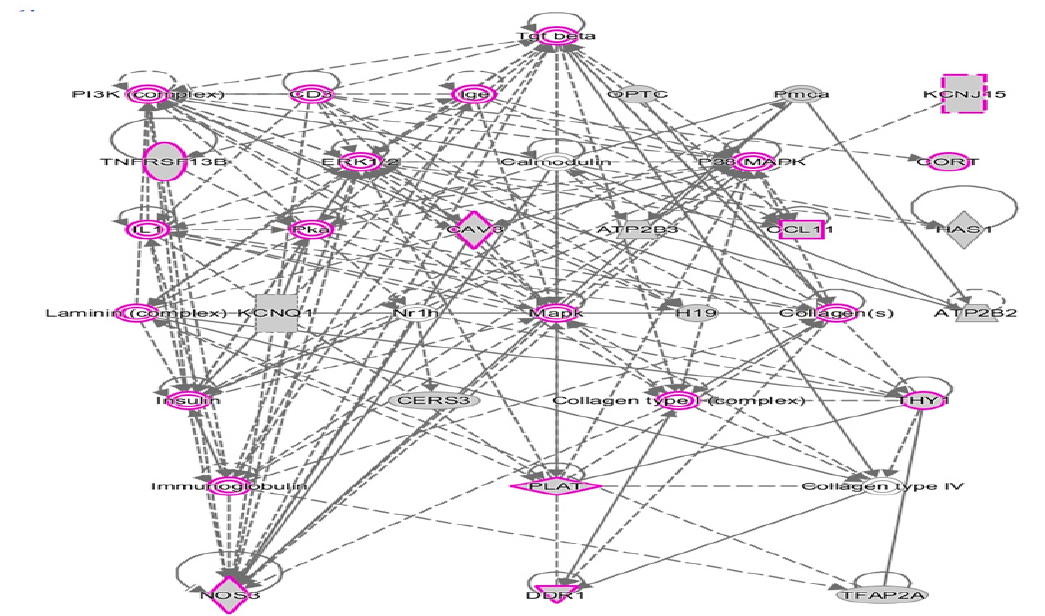
Figure 6. Hierarchical layout of top network of DAGs shared among 3 subphenotypes of ASD and the combined case group. Genes outlined in purple are involved in inflammatory responses.